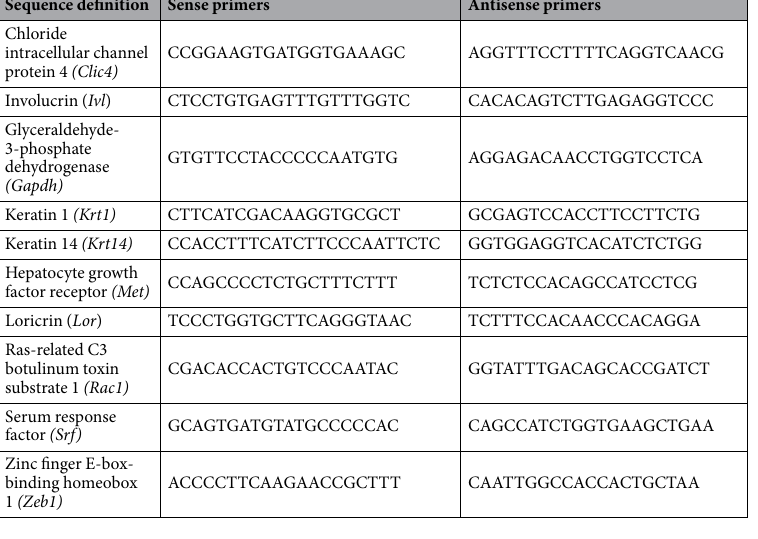
Table 2. RT-qPCR